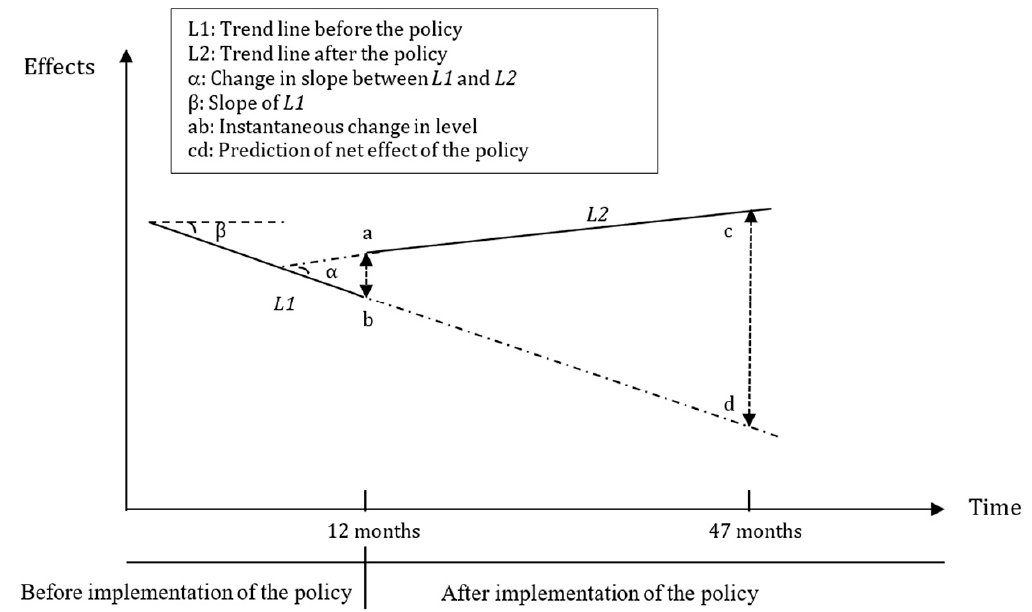
Figure 1. Graphic illustration of interrupted time series model and measuring the policy effects based on trend lines for data points before and after the policy.